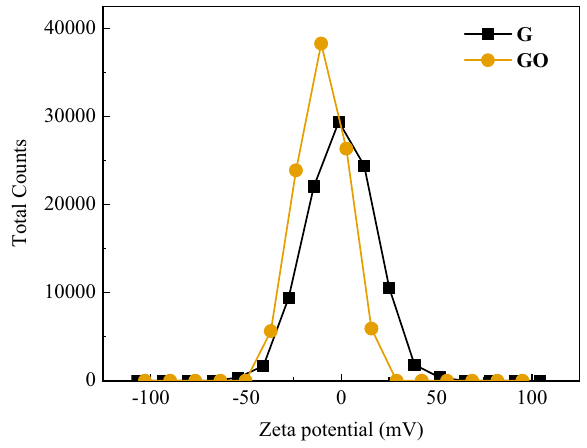
Figure 2: Zeta potential distribution of G and